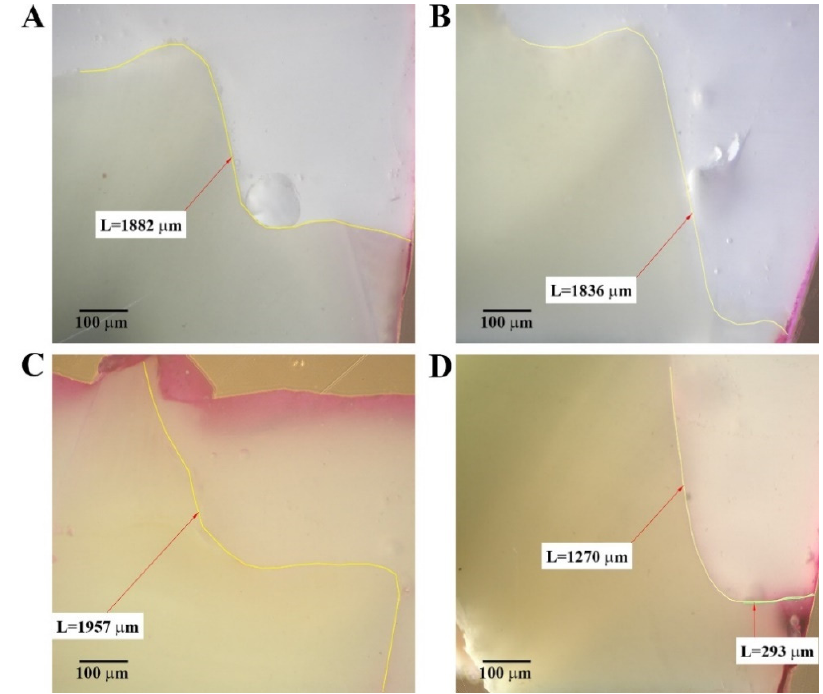
Figure 2. Adhesion of some experimental materials. Good adhesion in cervical area of enamel-located cavities restored with AX by bulk fill technique (group I–AX B) ( A ) and proximal wall technique (group V–AX) ( B ); good occlusal adhesion of an ES restoration (group III—ES) and ( C ); cervical microleakage of an ES restoration in a cementum-located cavity ( D ). Arrow = length ( µ m). The highest mean value of MLKd for the enamel-located restorations (sections A1 and B1) was recorded for group II (741.2 µ m), and the lowest microleakage mean value was recorded for group V (133.2 µ m). For the cementum-located restorations (sections A0 and B0), the highest mean value of MLKd was recorded for group I (851.6 µ m), and the lowest value